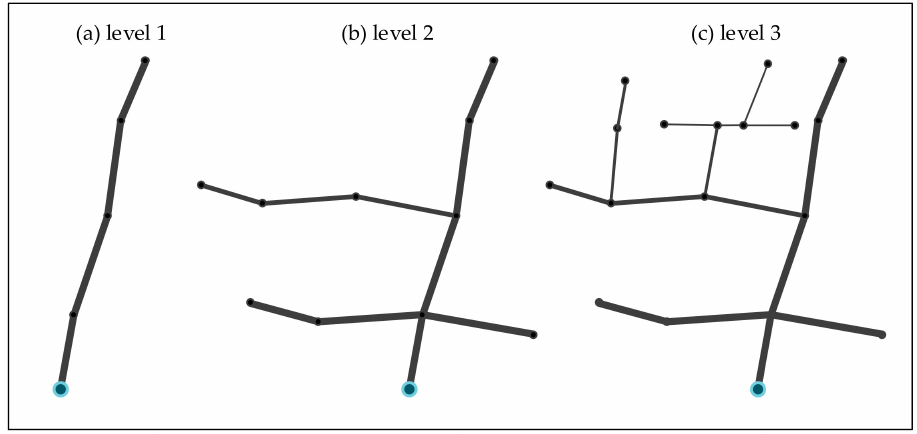
Figure 5. Classification results for the example storm sewer network in Figure